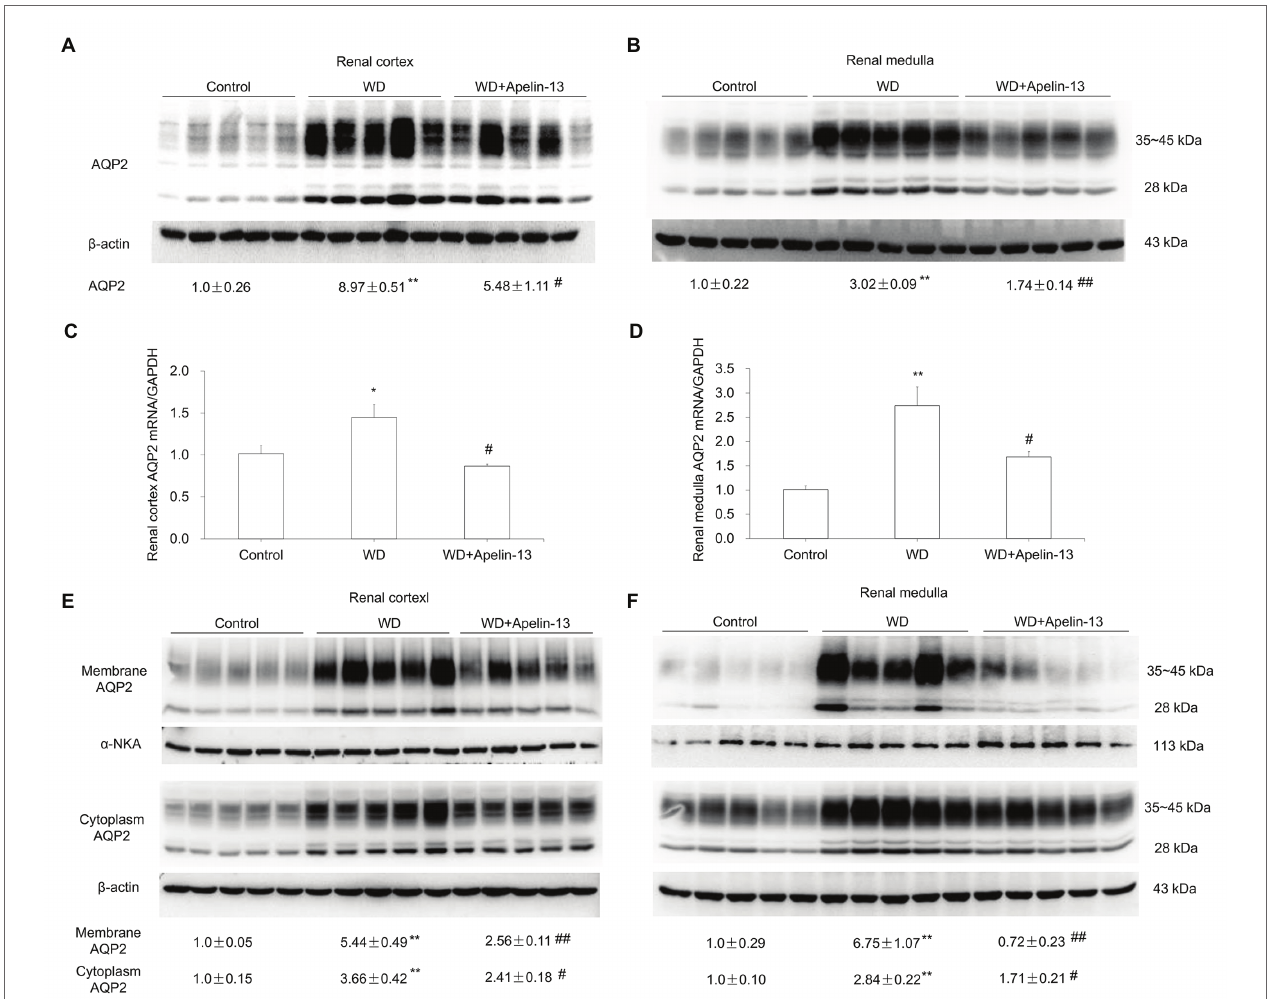
FIGURE 2 | Effect of apelin-13 on aquaporin 2 (AQP2) expression in the renal cortex and medulla in WD mice. (A,B) Representative immunoblotting and densitometric analysis of AQP2 protein expression in the kidney cortex (A) and medulla (B) , the protein abundances were normalized by β -actin (C,D) qRT-PCR analysis of renal AQP2 mRNA expression in the kidney cortex (C) and medulla (D) . The expression was normalized by GAPDH . (E,F) Representative immunoblotting and densitometric analysis of membrane and cytosolic fraction AQP2 protein expression in the kidney cortex (E) and medulla (F) . The abundance of AQP2 in the membranous and cytoplasmic factions was normalized by α -NKA and β -actin, respectively. n = 5 per group. Data are mean ± SEM. * p < 0.05 and ** p < 0.01 vs. Control; # p < 0.05 and ## p < 0.01 vs.